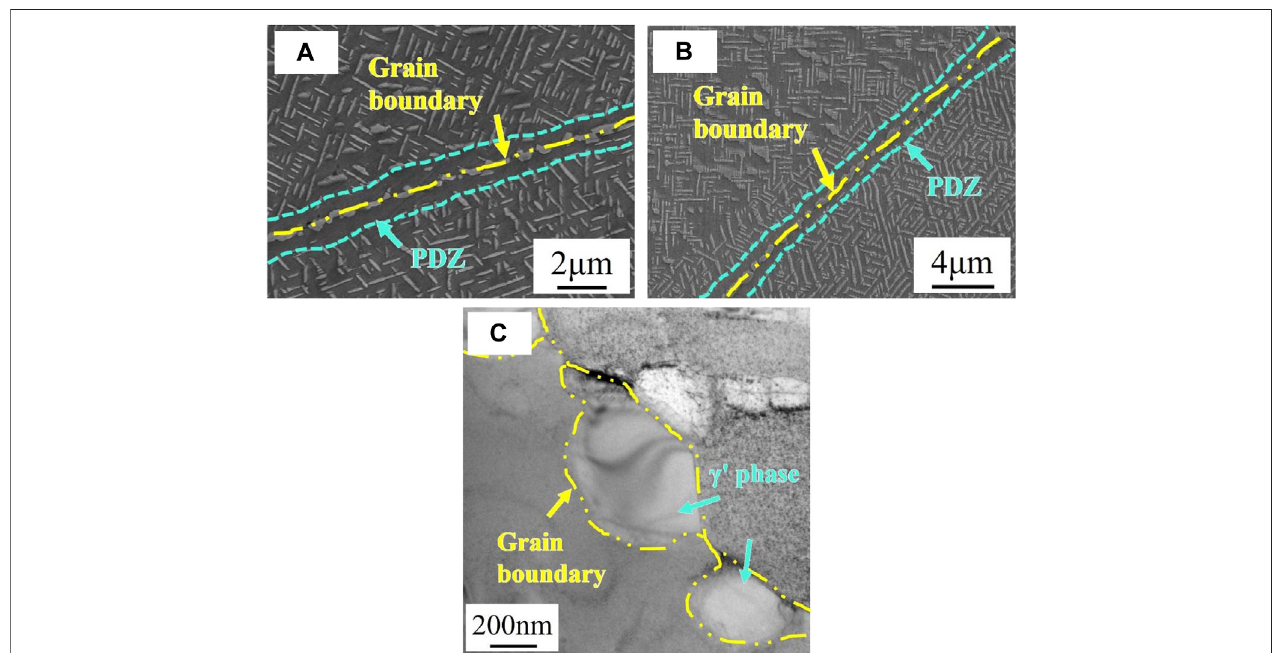
FIGURE 10 | SEM and TEM micrographs of superalloys aged at 1073 K: (A) 2Cr for 512 h, (B) 2Mo for 512 h, and (C) 2Mo for 32 h.